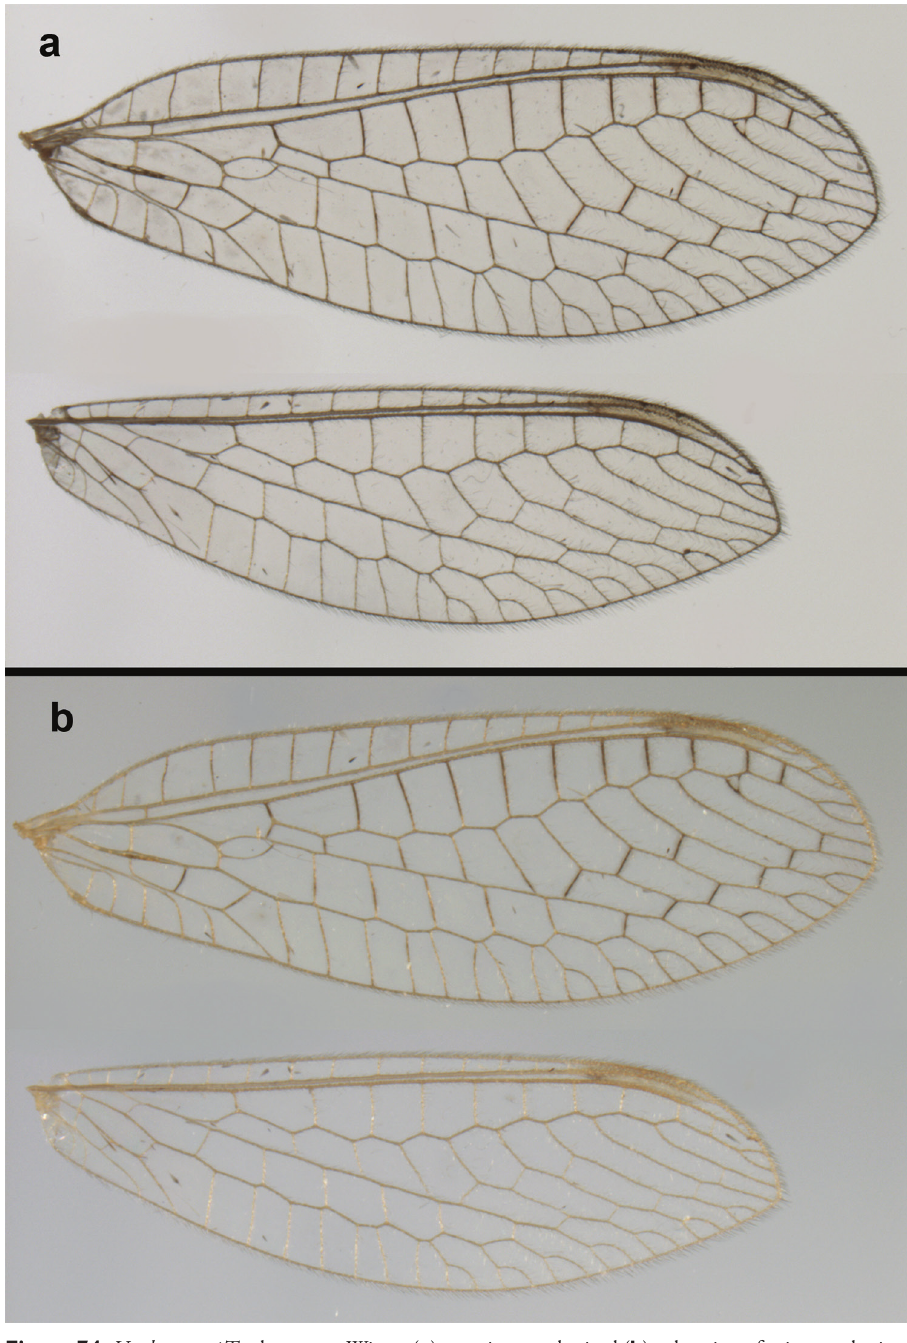
Figure 74. Ungla pennyi Tauber, sp. n. Wings, ( a ) venation emphasized ( b ) coloration of veins emphasized (Costa Rica, Cartago, holotype, male,